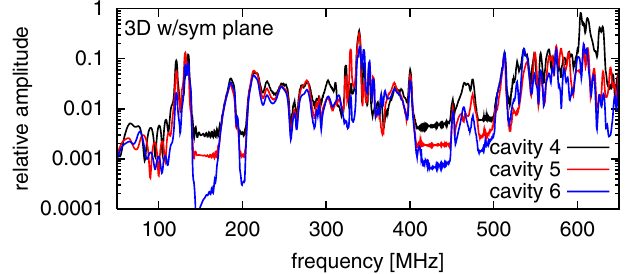
FIG. 5. (Color) Field resonances of the IVA cavities determined using the full RITS-6